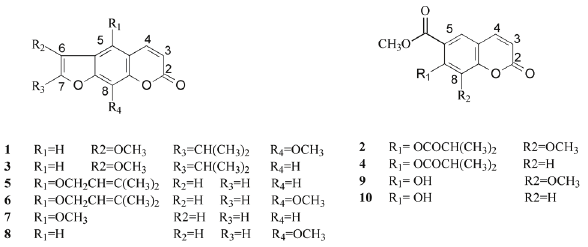
Figure 1: Structures of isolated